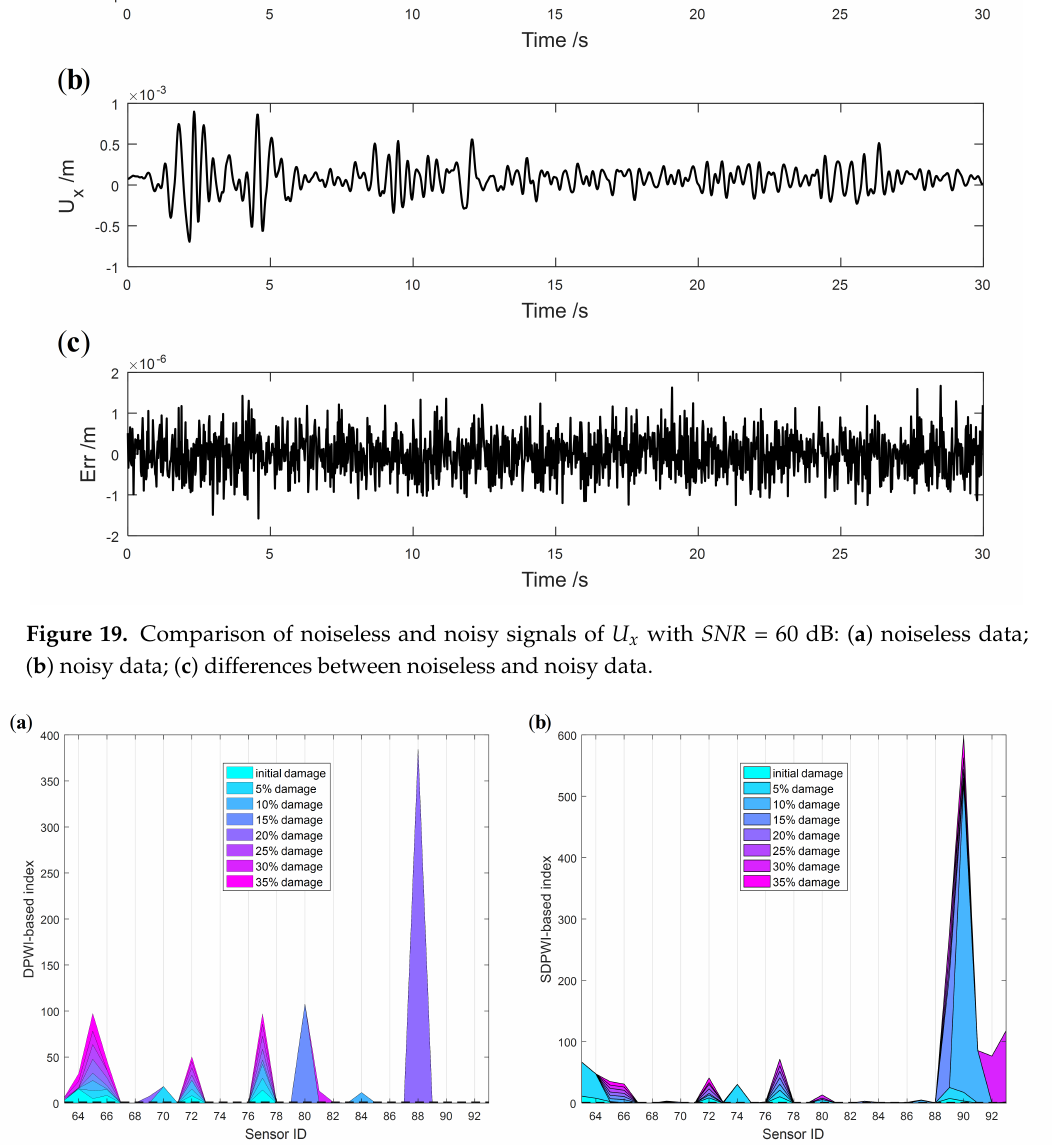
Figure 20. Damage identification results of the CCGB using noisy responses: ( a ) Damage I; ( b ) Damage